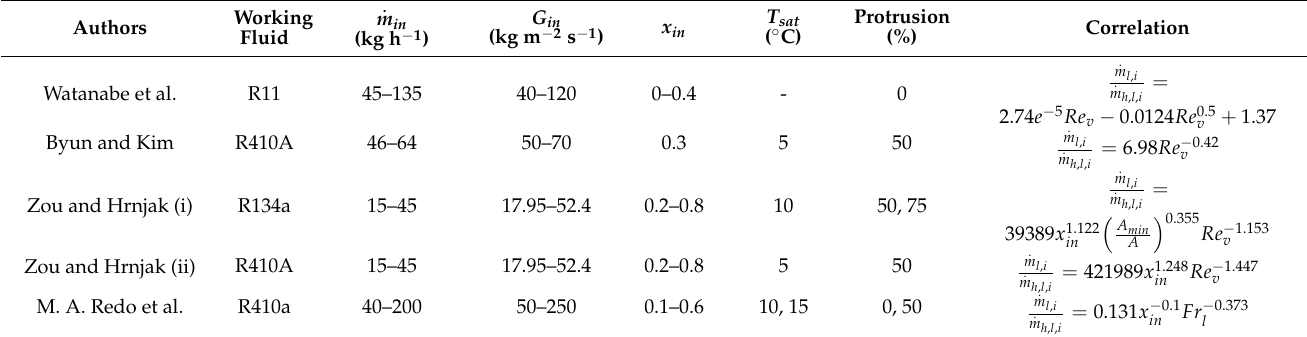
Table 3. Conditions and empirical correlation of previous studies.